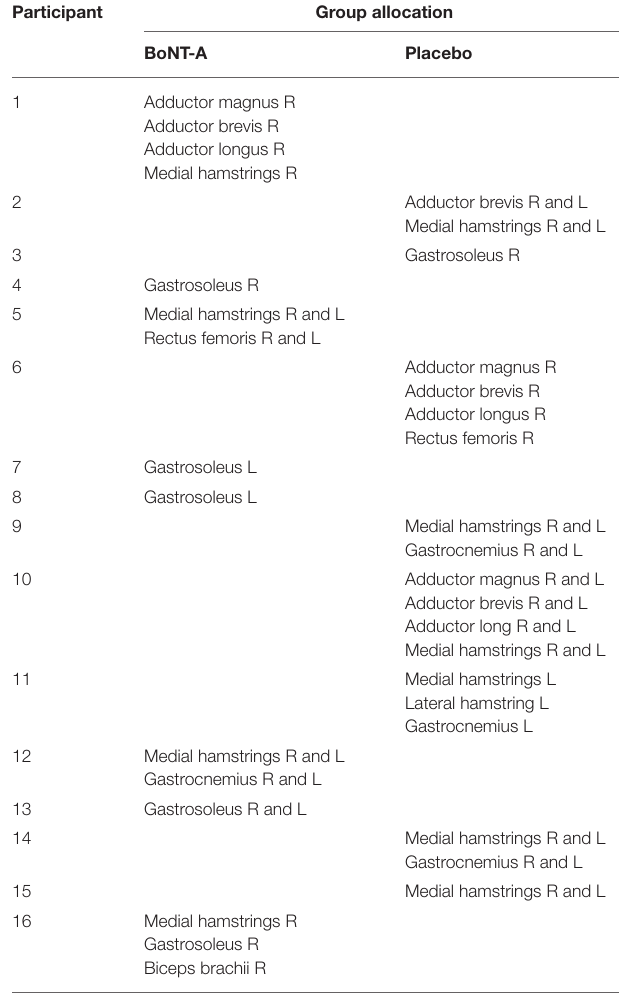
TABLE 3 | Injected muscles per participant, with treatment allocation.